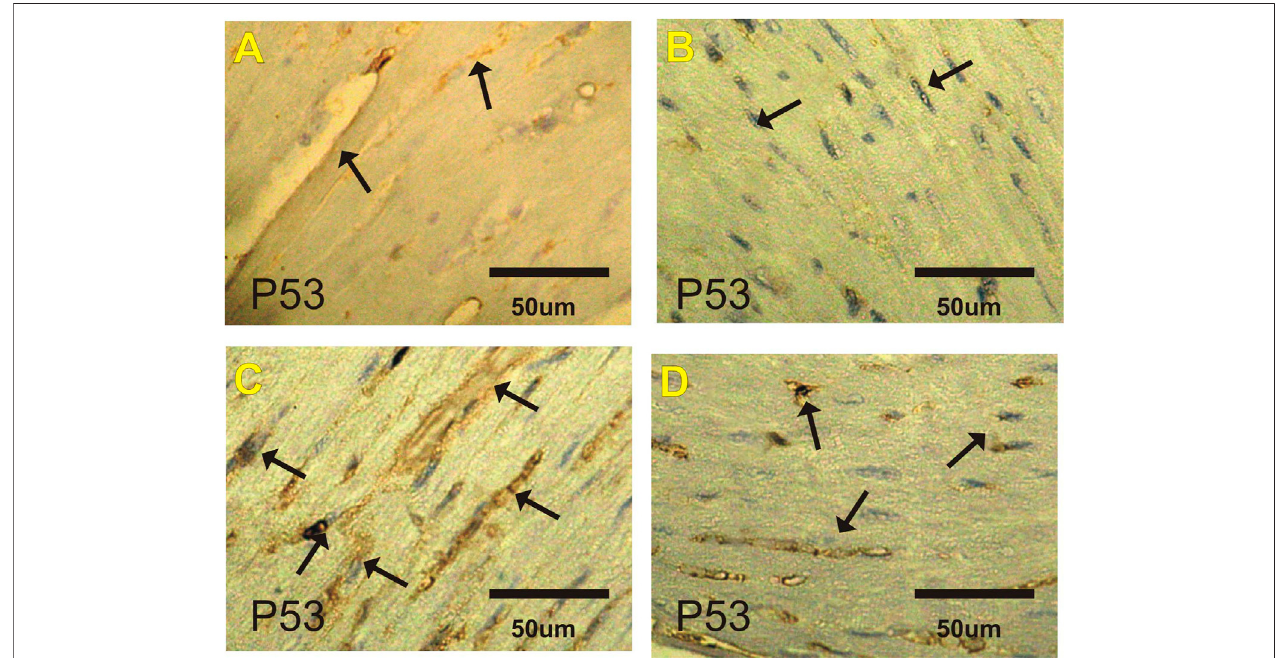
FIGURE 3 | Photomicrographs of heart sections from the different experimental groups stained with p53-ir. Faint p53-ir reactions (arrows) are shown in the (A) control and (B) costus groups. (C) Severe positive reactions (arrows) for p53-ir are shown in the EST group. (D) Mild reactions (arrows) for p53-ir are shown in the EST group treated with costus. p53-ir, p53 immunoreactivity; EST, Ehrlich solid tumor.